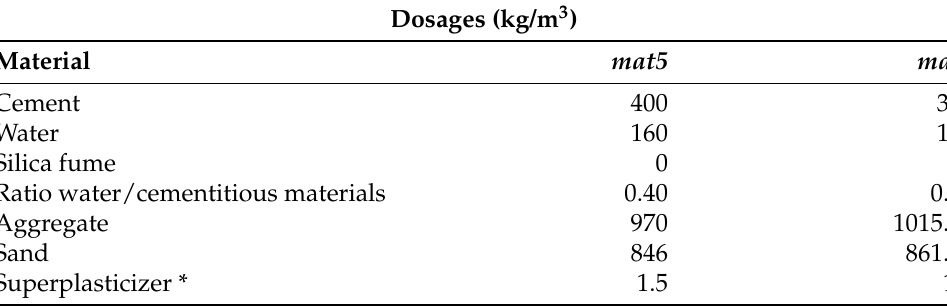
Table 2. Dosages of the studied materials.